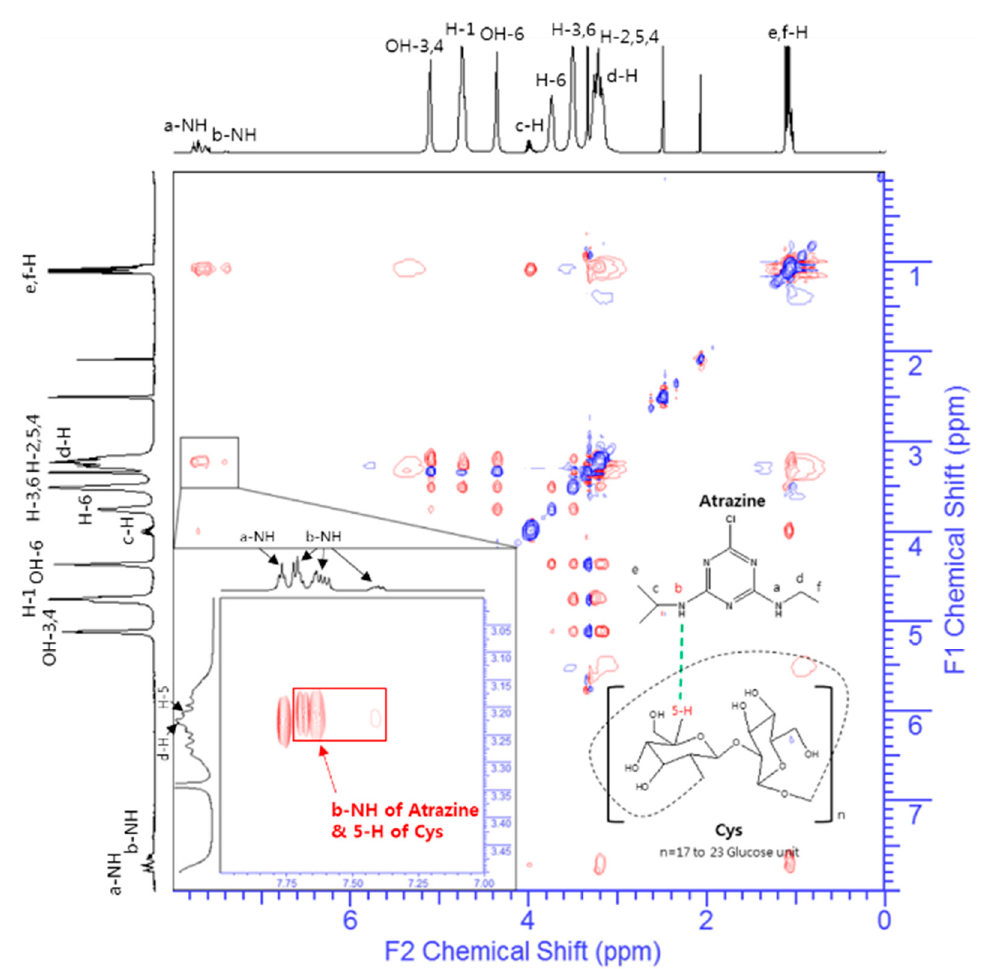
Figure 8. ROESY spectrum for atrazine/Cys inclusion complex.